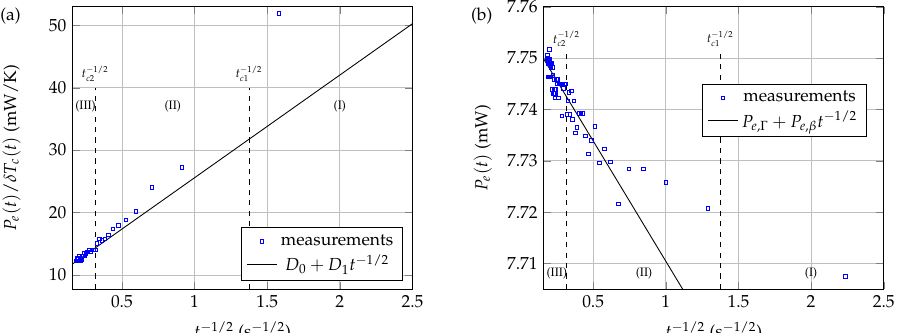
Figure 17. Signal processing of the experimental thermal signals obtained by constant voltage excitation in the case of NTC3 immersed in pure glycerol at rest, when L i = 5.0mm, v 0 = 6.90V, and T 0 = 25 ◦ C: ( a ) Kharalkar et al. signal processing; ( b ) CTHT-type signal processing. Fitting curves (straight lines) were calculated using data belonging only to time domain